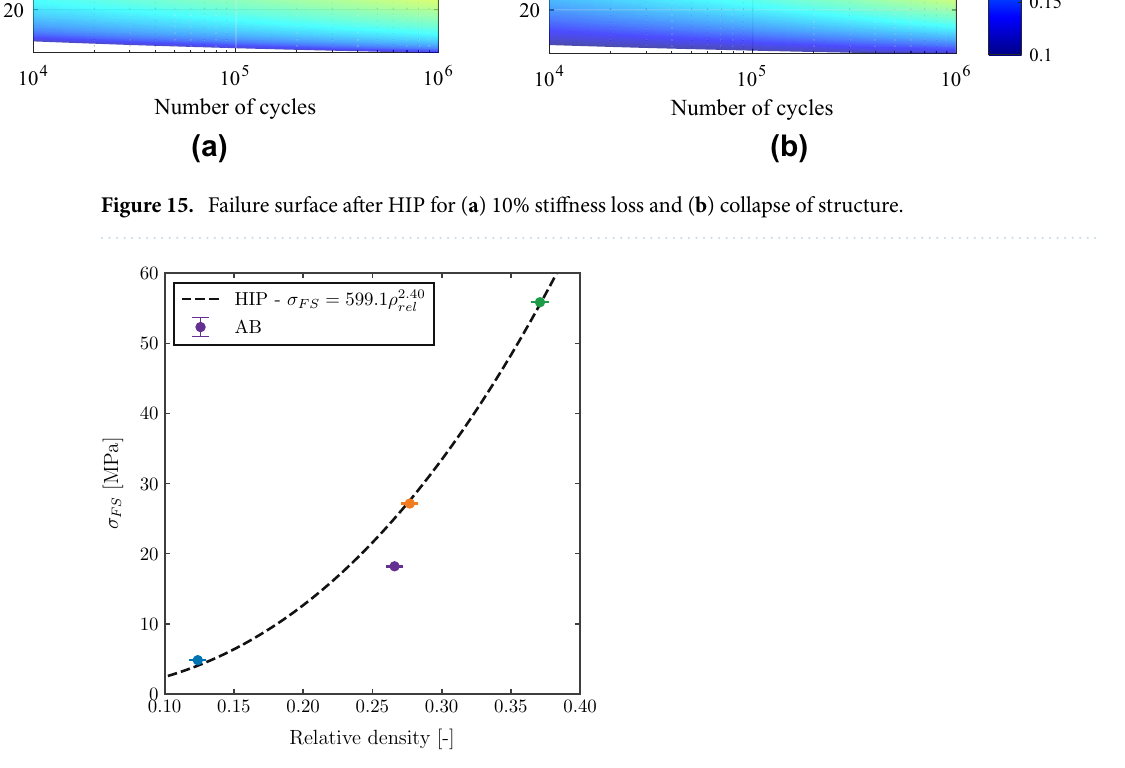
6 Figure 16. Fatigue strength at 10 cycles of FCCm structures for different relative densities and post